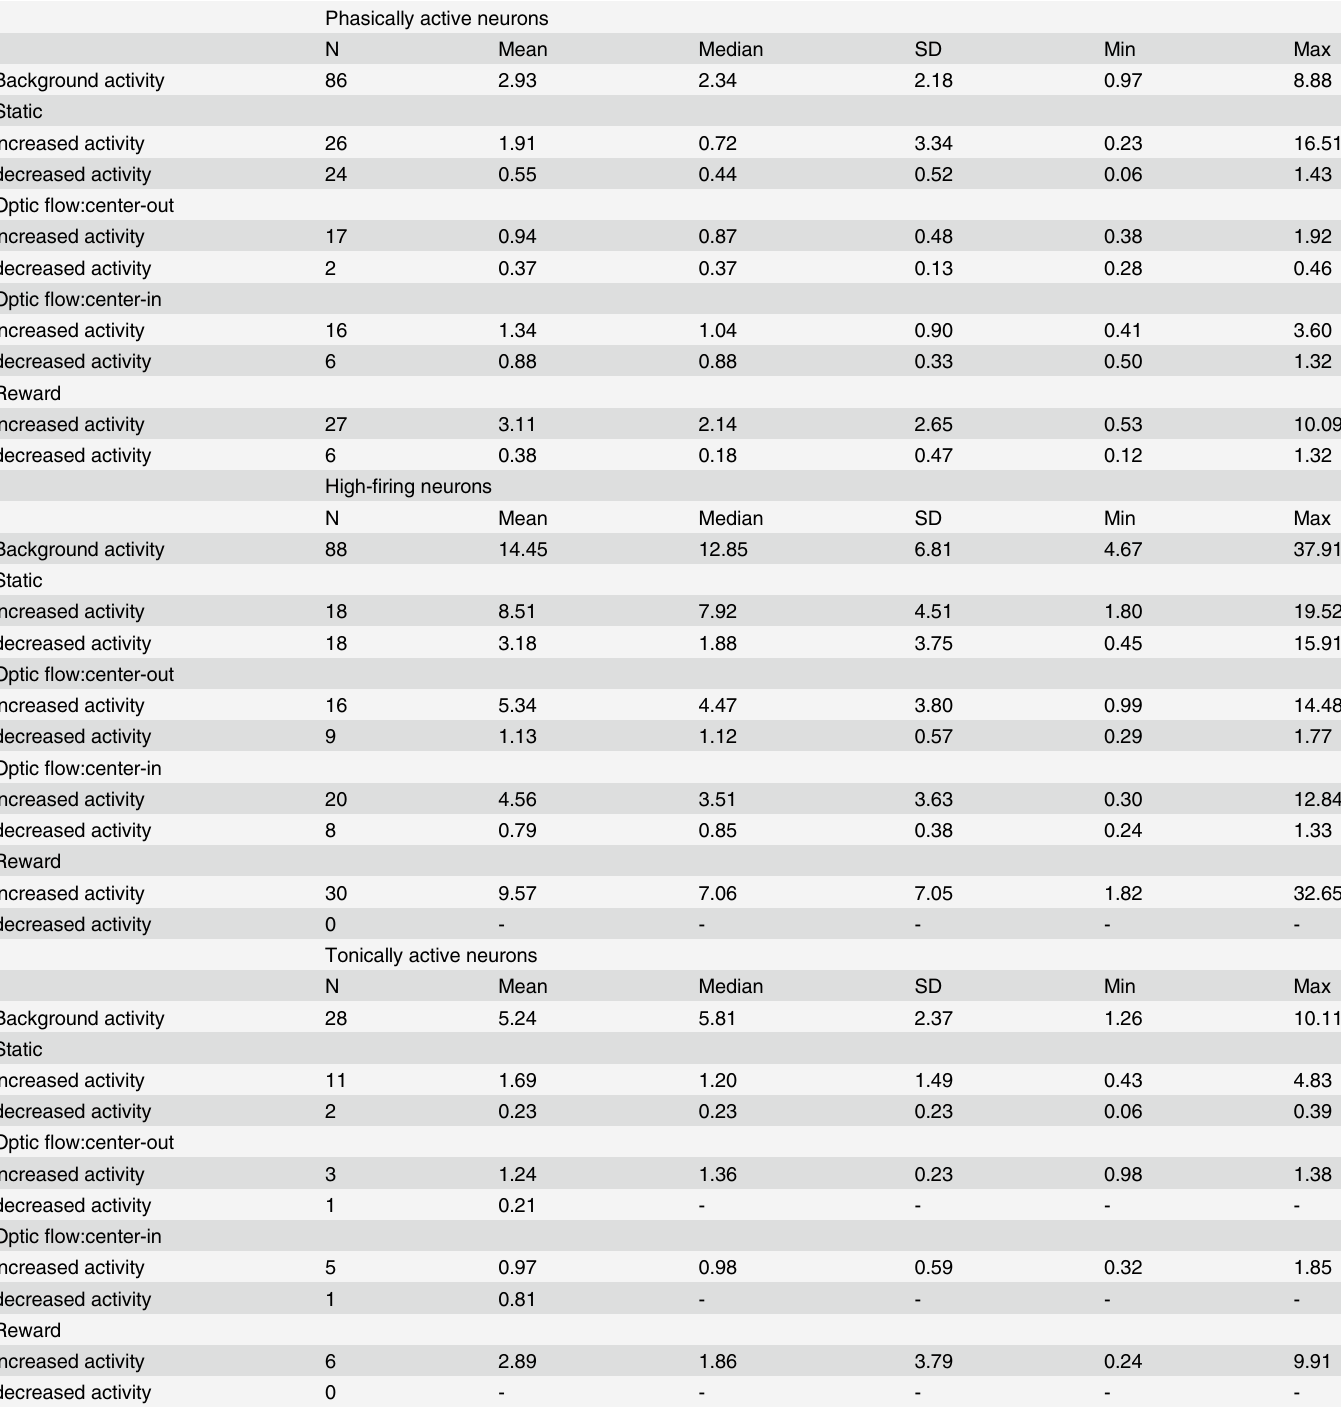
absolute values of the net